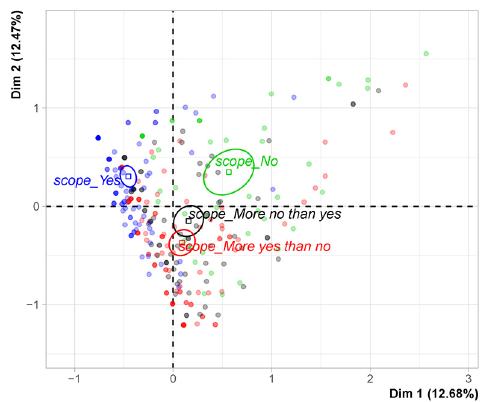
Figure A4. MCA. Distribution of respondents by attitudes towards reduced job scope.